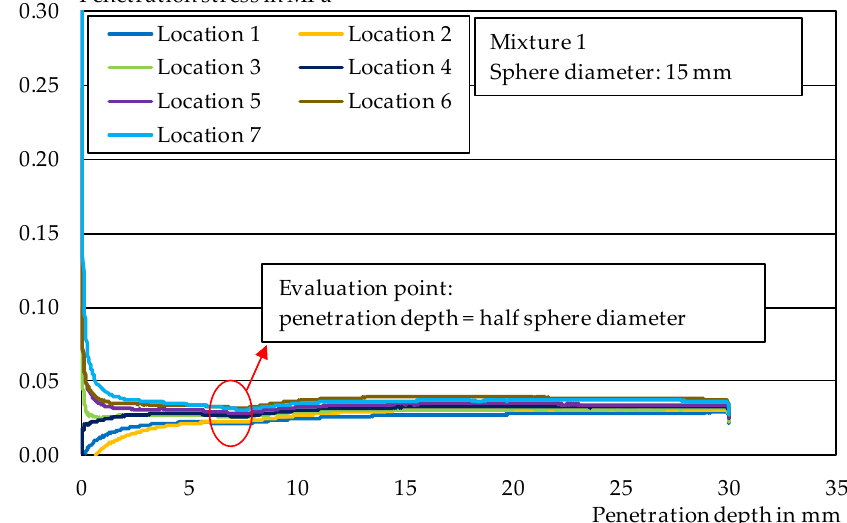
Figure 12. Results of the penetration tests carried out on mixture M1 with sphere diameter 15 mm.